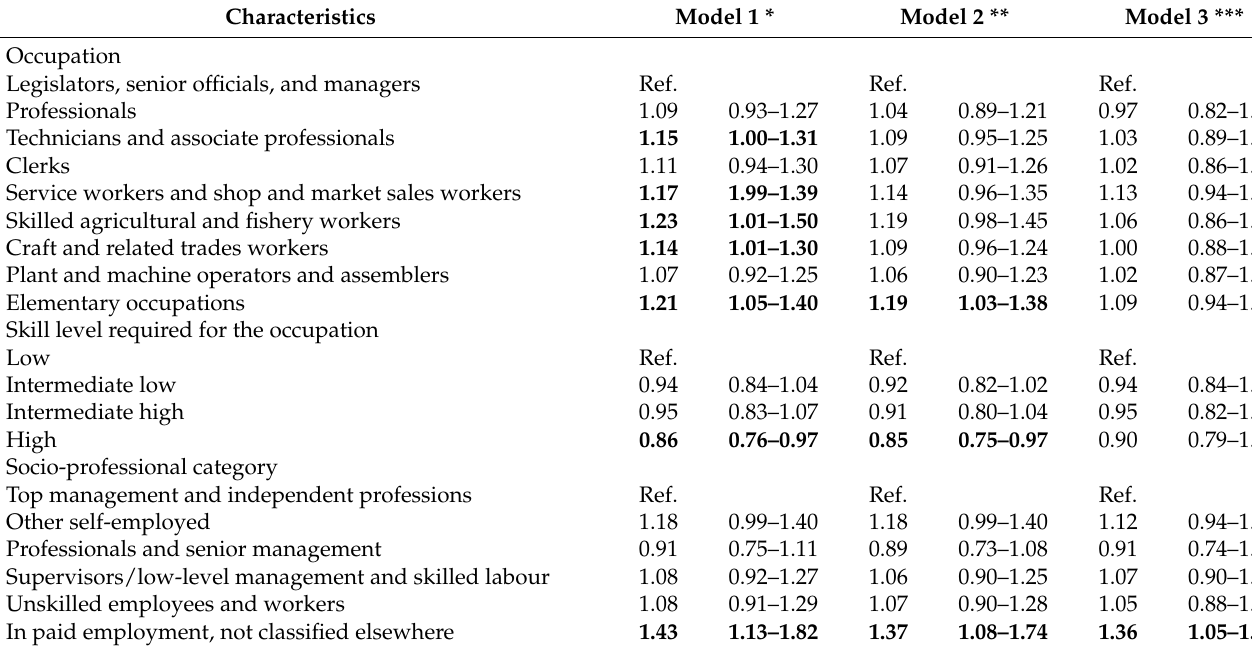
Table 3. Hazard ratios and associated 95%-confidence intervals for lung cancer relative survival by work-related variables among males aged 18–85 in French-speaking Switzerland (1990–2014).